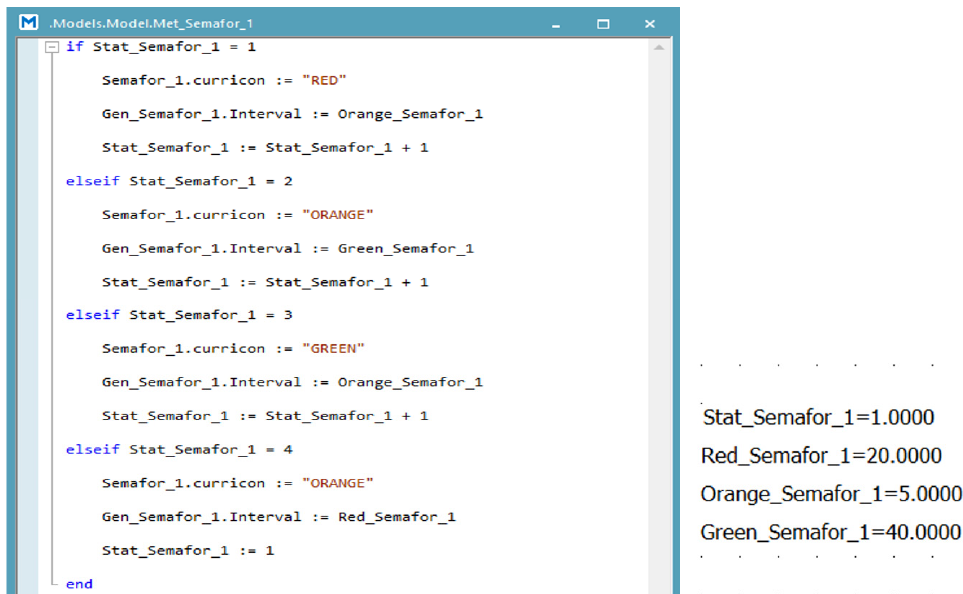
Figure 8. Road light signaling method for vehicles and defining TLS variables for vehicles.